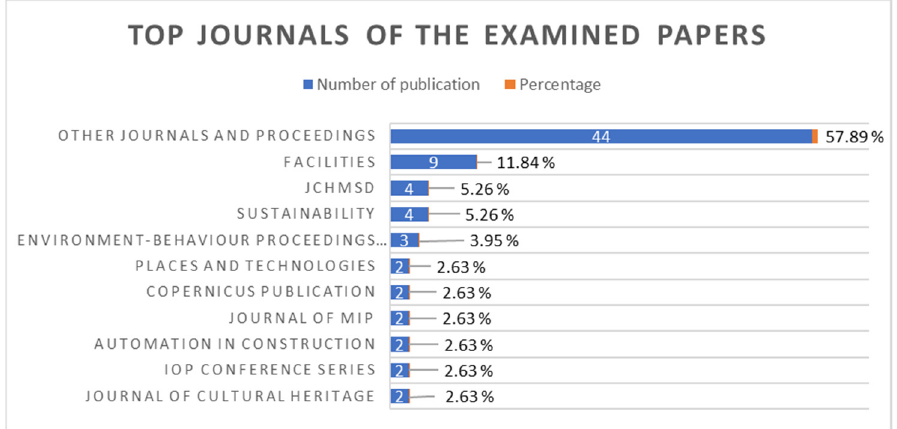
Figure 4. Top journals of UHFM-related articles.